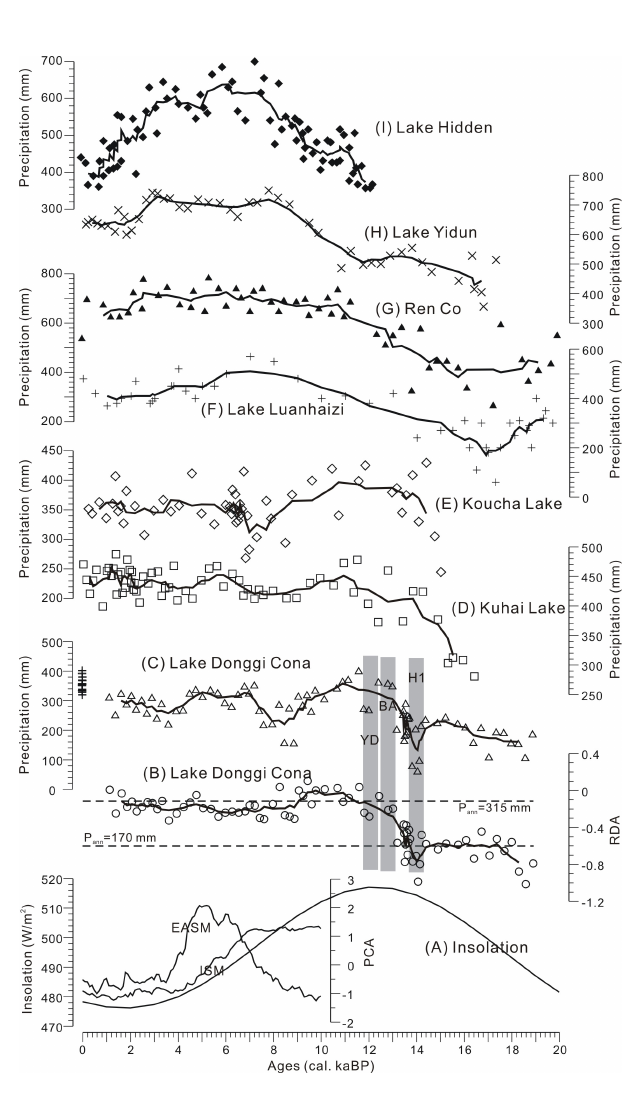
Fig. 8. (A) : summer (June) solar insolation at 35 ◦ N (after Laskar et al., 2004) and Asian summer monsoon indices (after Wang et al., 2010). (B) : first RDA axis scores from Lake Donggi Cona, together with the thresholds derived from the MRT analysis (dashed lines).